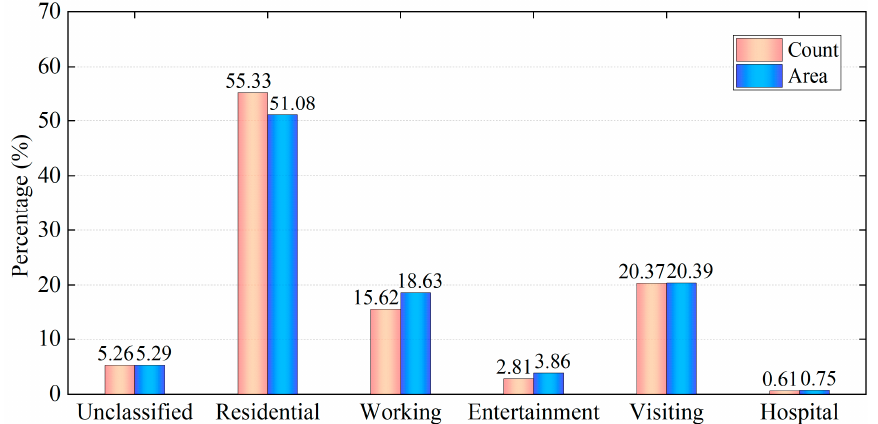
Figure 20. Statistics on the count and area of identified building types in the main central area of Beijing.